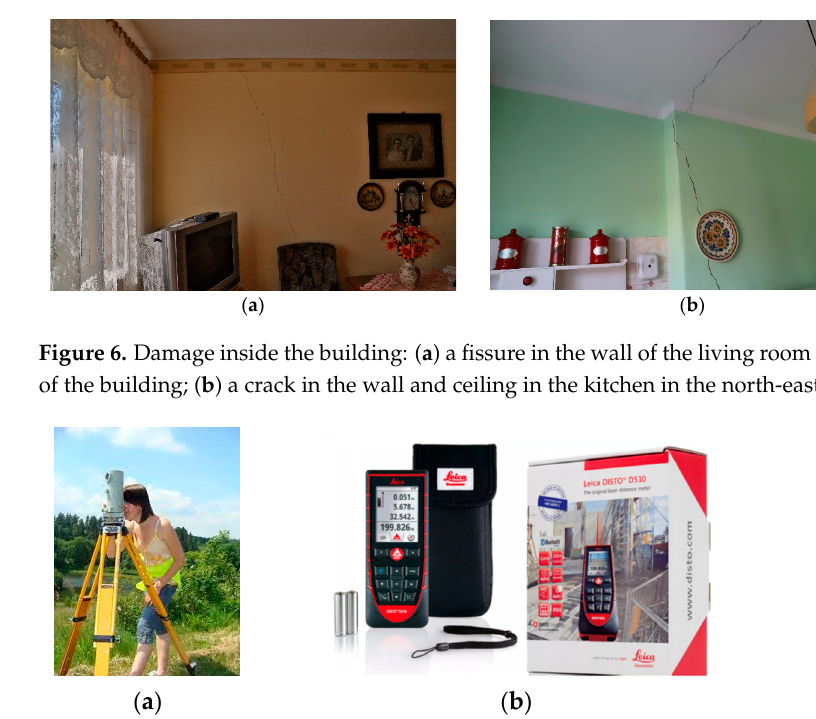
Figure 6. Damage inside the building: ( a ) a fissure in the wall of the living room in the south-east part of the building; ( b ) a crack in the wall and ceiling in the kitchen in the north-east part of the building. Leica Geosystems, Warsaw, Poland with an accuracy of 1 mm—Figure 7b), the values of Appl. Sci. 2023 , 13 , x FOR PEER REVIEW inclinations and curvatures of the ground and the building have been calculated.